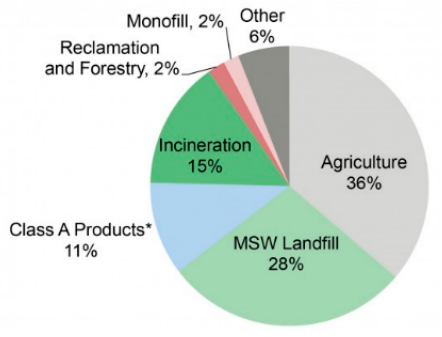
Figure 1. Biosolids use and disposal (note: * denotes Class A sludges; source: US Wastewater Treatment 3 ). Table 1. Rise in average US tipping fees: 2018 to 2019. (Source: wastetodaymagazine.com) Region